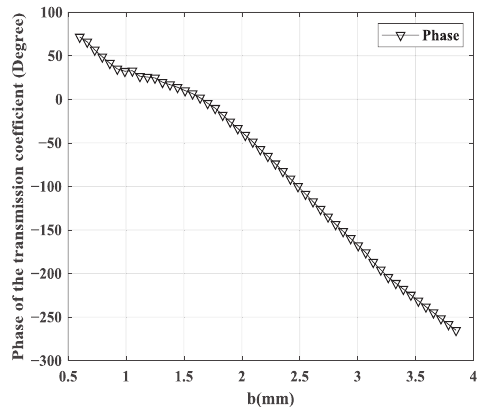
Figure 3. Phase of the transmission coefficient at the normal